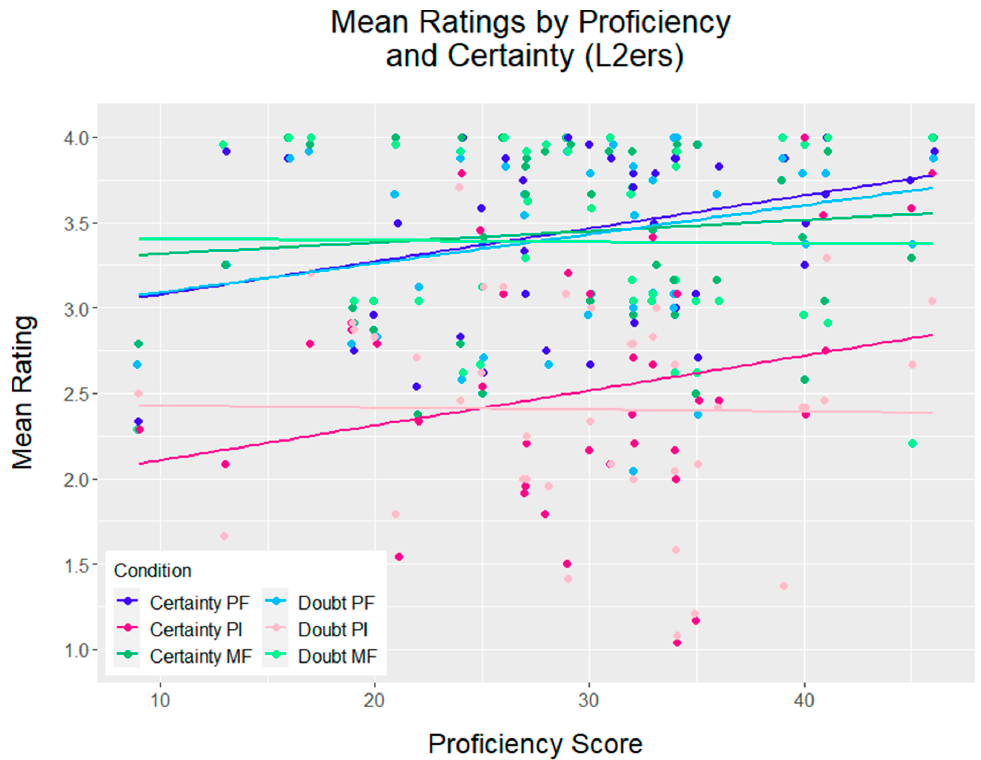
Figure 4. Proficiency and mean ratings by verb form and certainty.